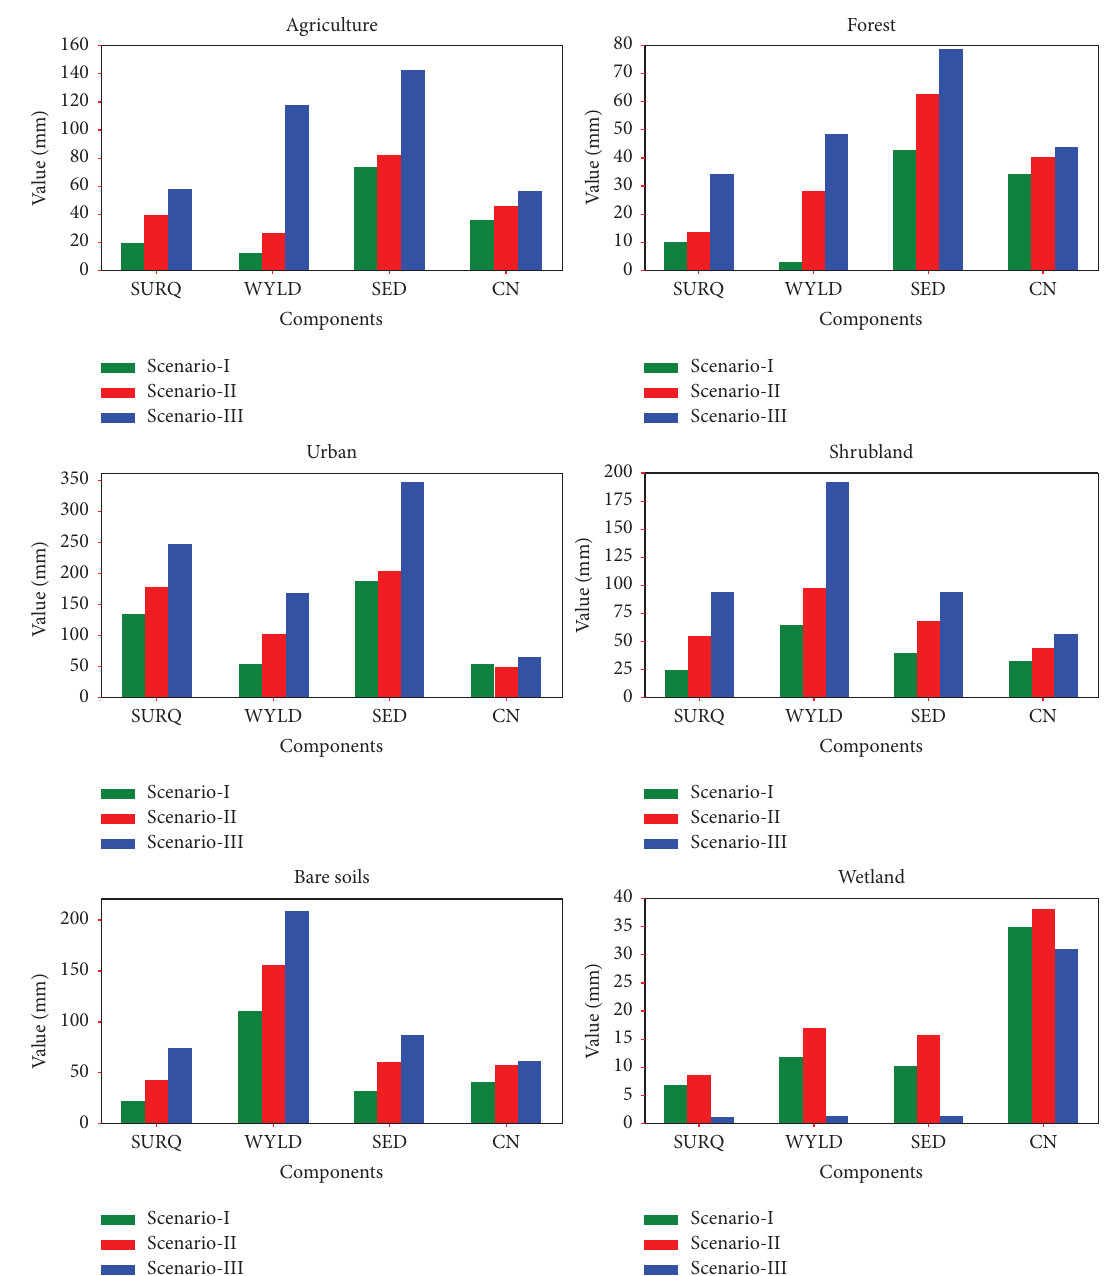
Figure 13: Te contribution of each LULC to cause surface runof, water yields, and sediment